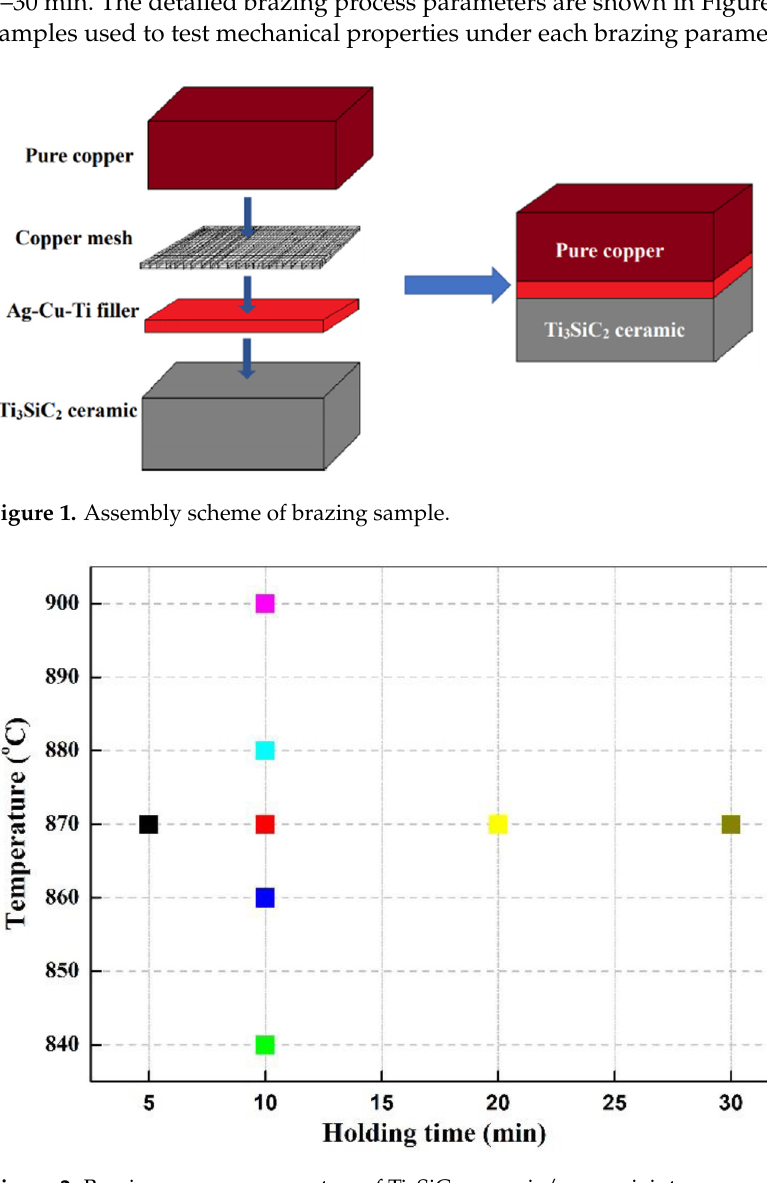
Table 1. Parameters of filler power and copper mesh.